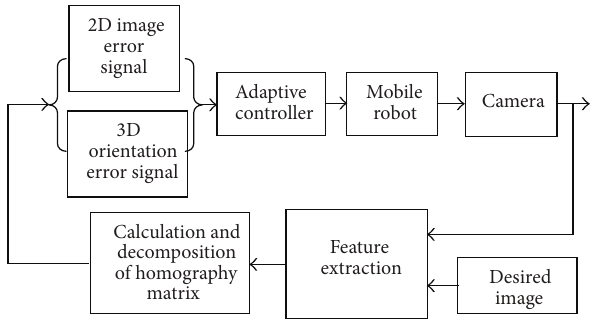
Figure 3: Visual servo regulation of the mobile robot with a monocular